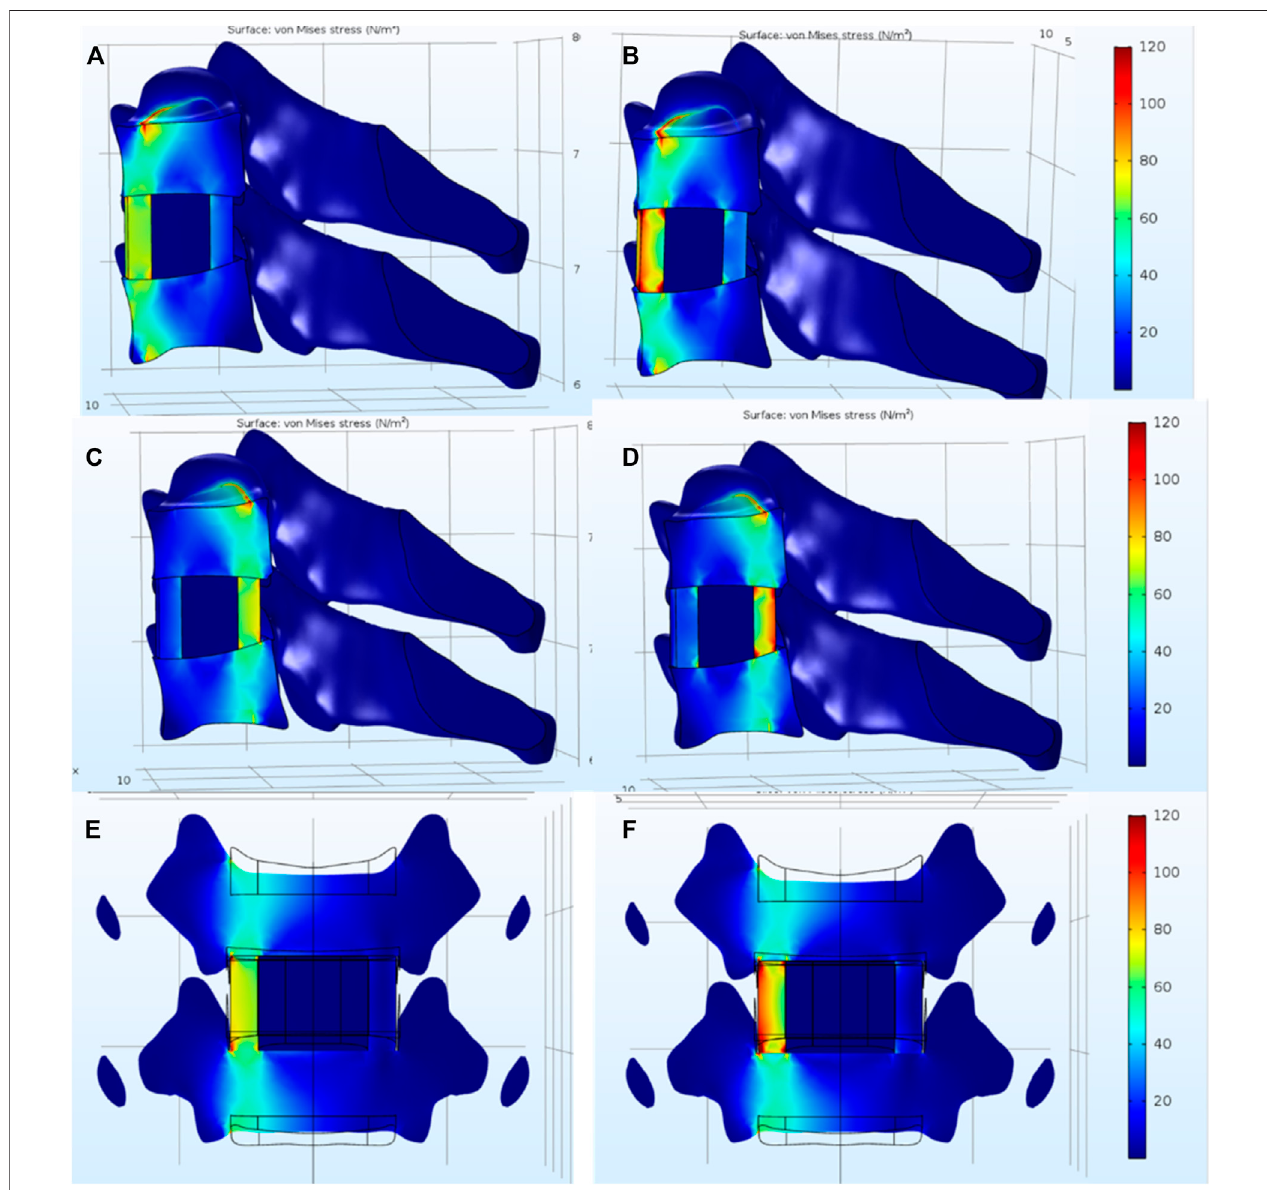
FIGURE 8 | Stress distribution under (A) ante fl exion, (C ) retro-extension, and (E) side bend with a SF/nHAp composite cage. Stress distribution under (B) ante fl exion, (D) retro-extension, and (F) side bend with a Ti alloy cage.